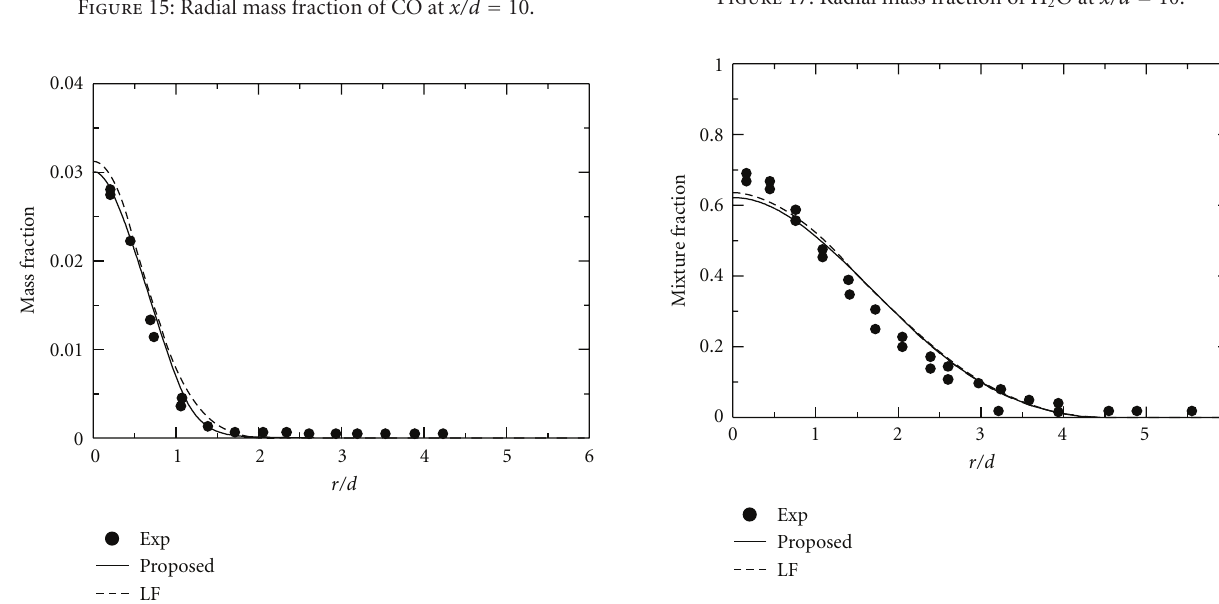
Figure 15: Radial mass fraction of CO at x/d = 10.